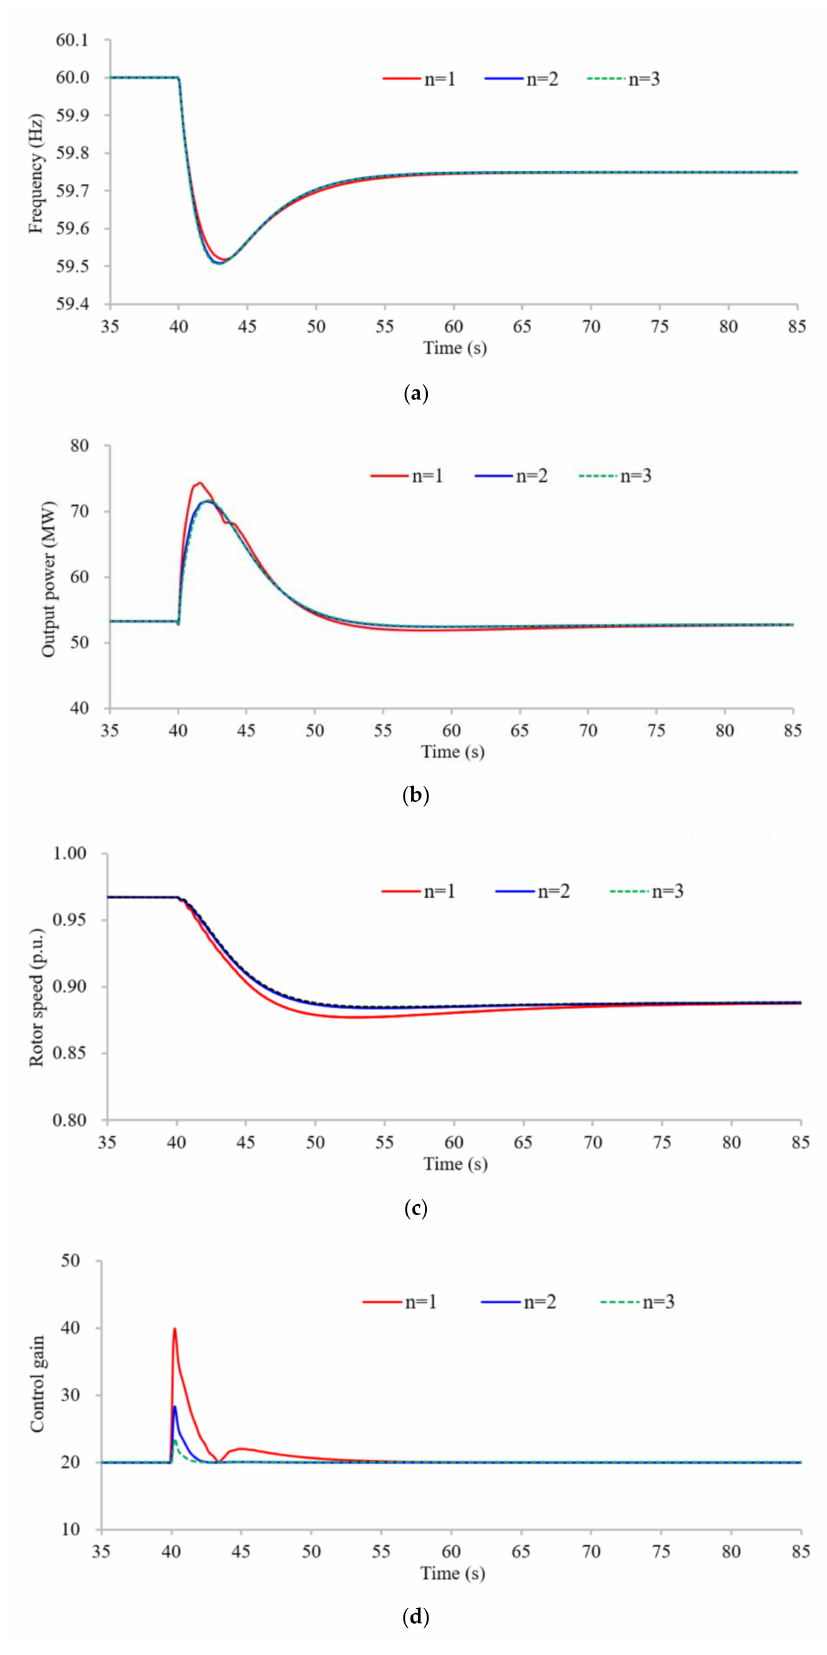
Figure 6. Simulation results for Case 1: ( a ) System frequencies; ( b ) Active power of the DFIG; ( c ) Rotor speeds; ( d ) Control